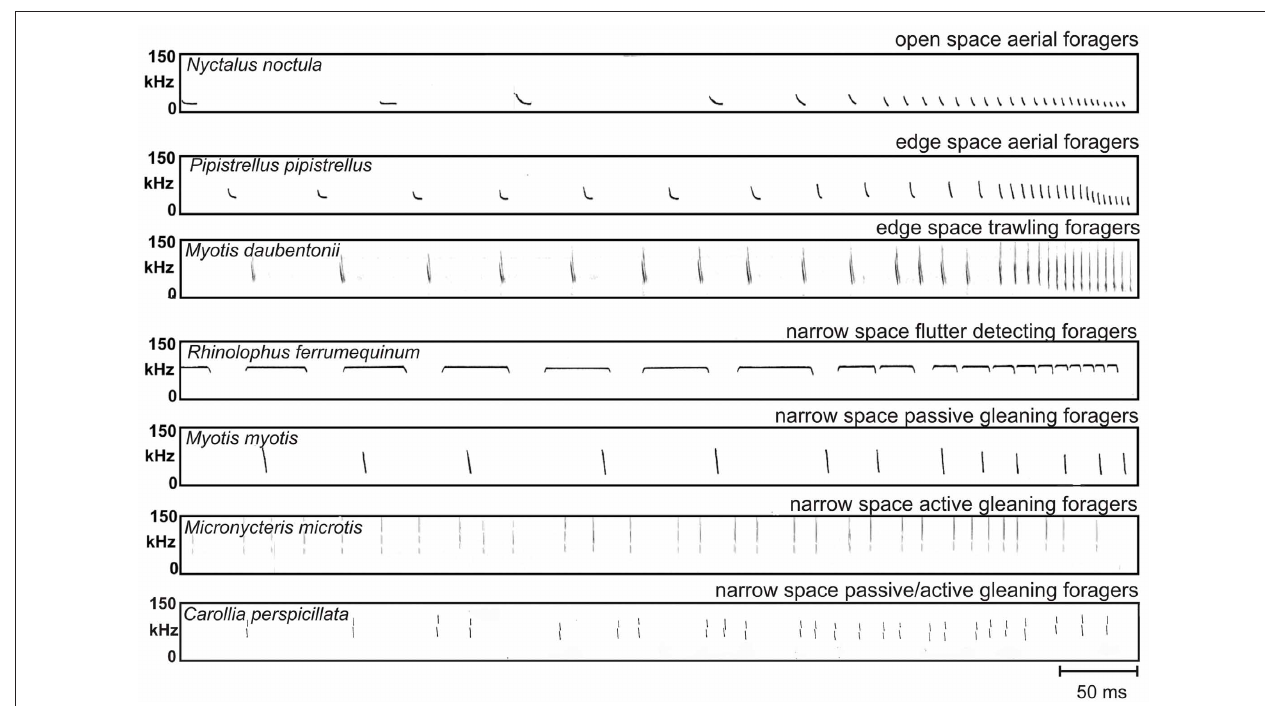
FIGURE 5 | Search and approach signals of a representative species from each guild. The approach sequences of open space and edge space foragers end with a terminal group consisting of buzz I and buzz II. Narrow space flutter detecting foragers maintain the CF-component of the calls even in the shortest signals of the terminal group. The approach sequences of all other narrow space gleaning foragers lack a distinct terminal group. The approach signals of narrow space passive gleaners are often arranged in groups, but